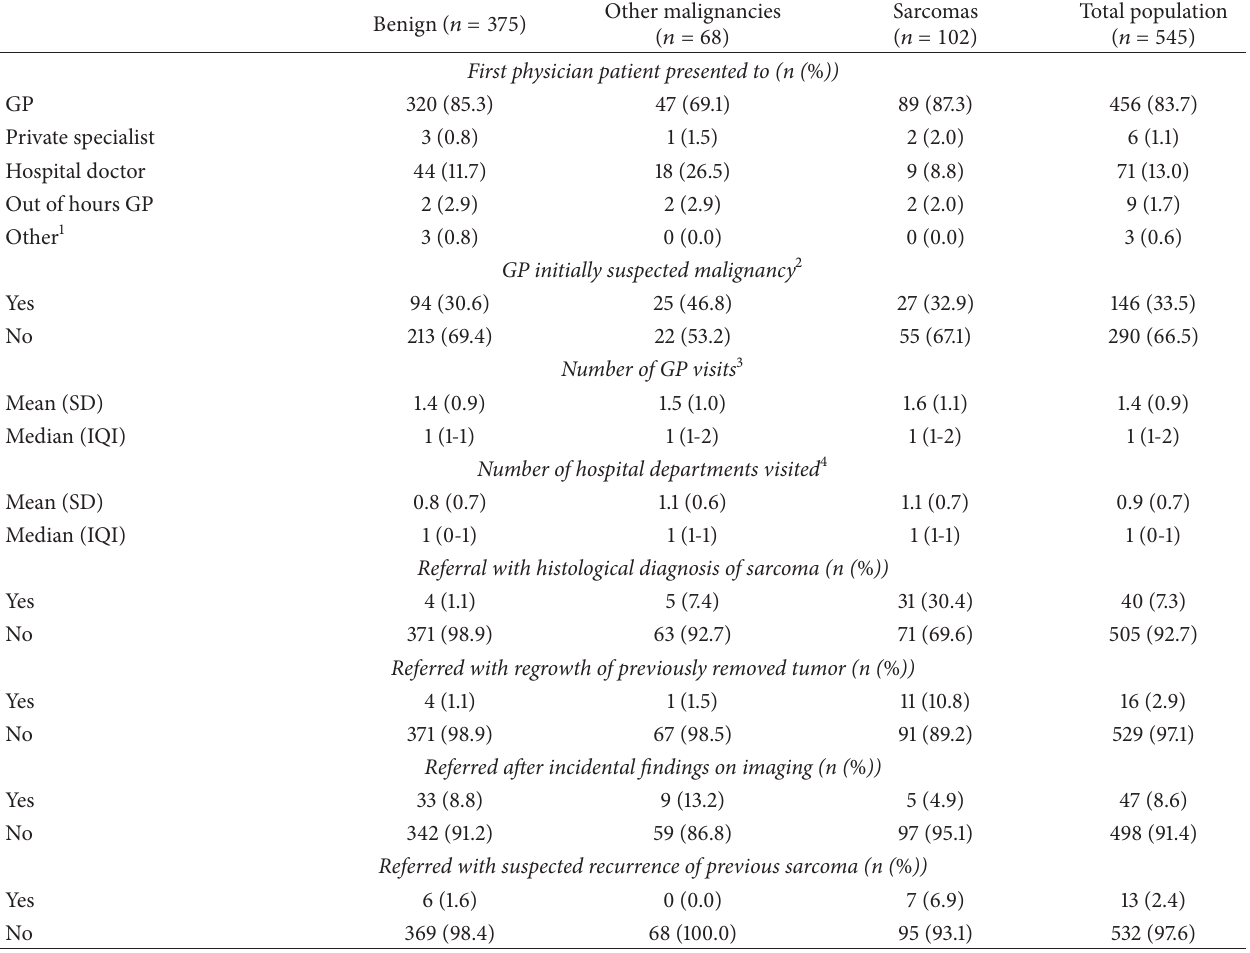
Table 4: Routes to diagnosis for 545 patients referred to the Cancer Patient Pathway for